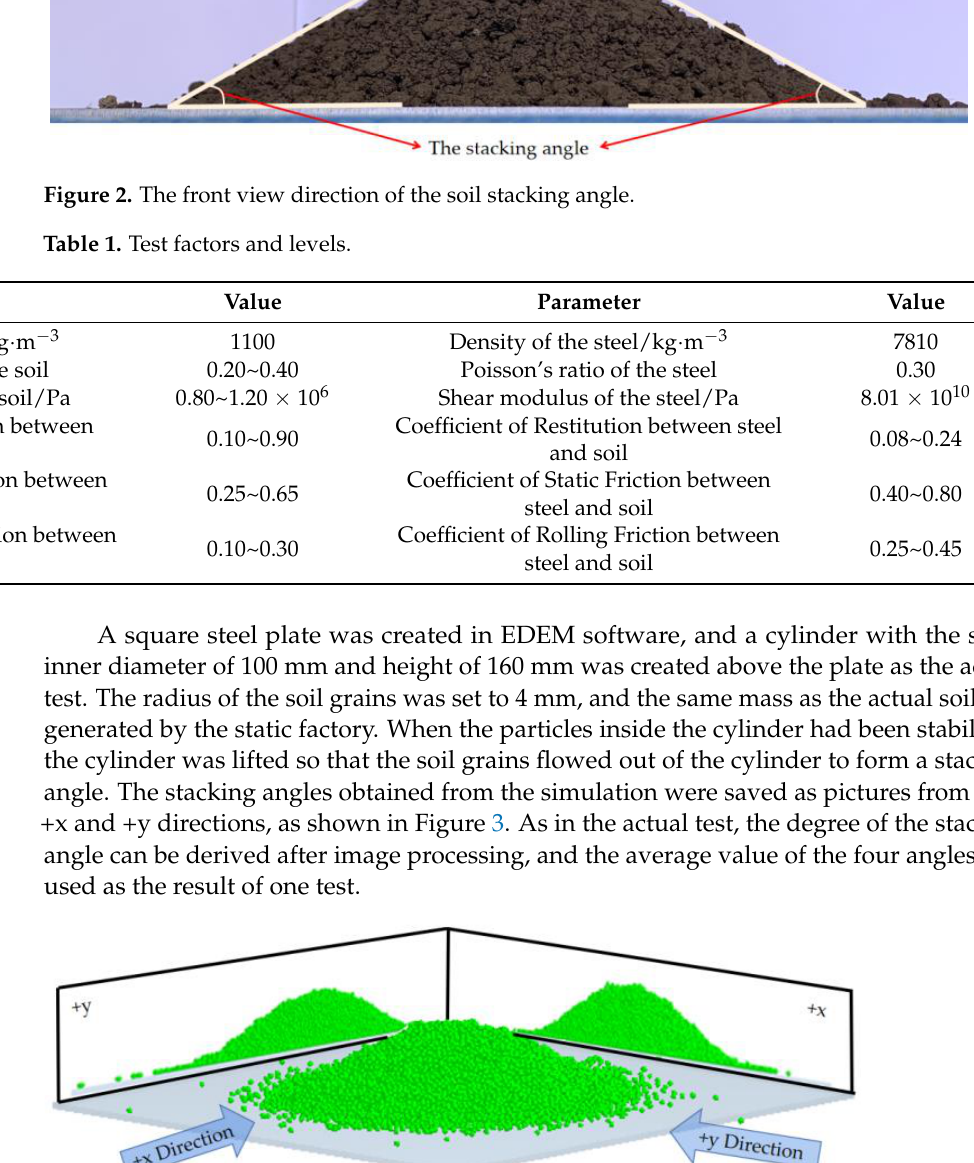
Figure 3. Simulation model of the soil stacking angle.